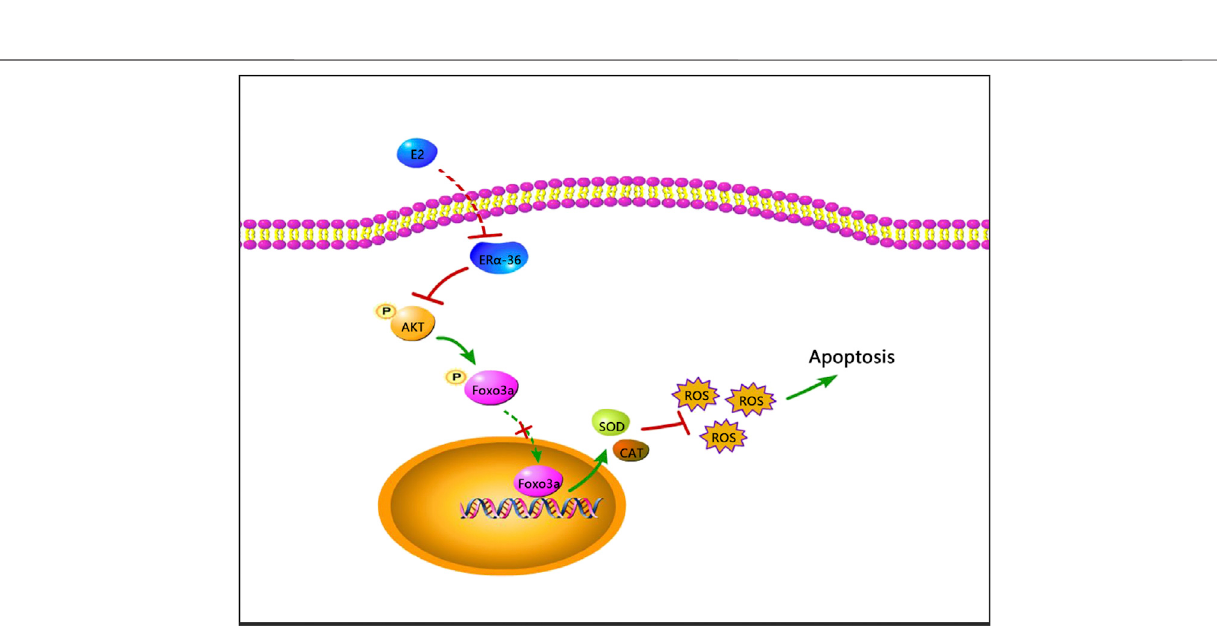
Frontiers in Pharmacology |